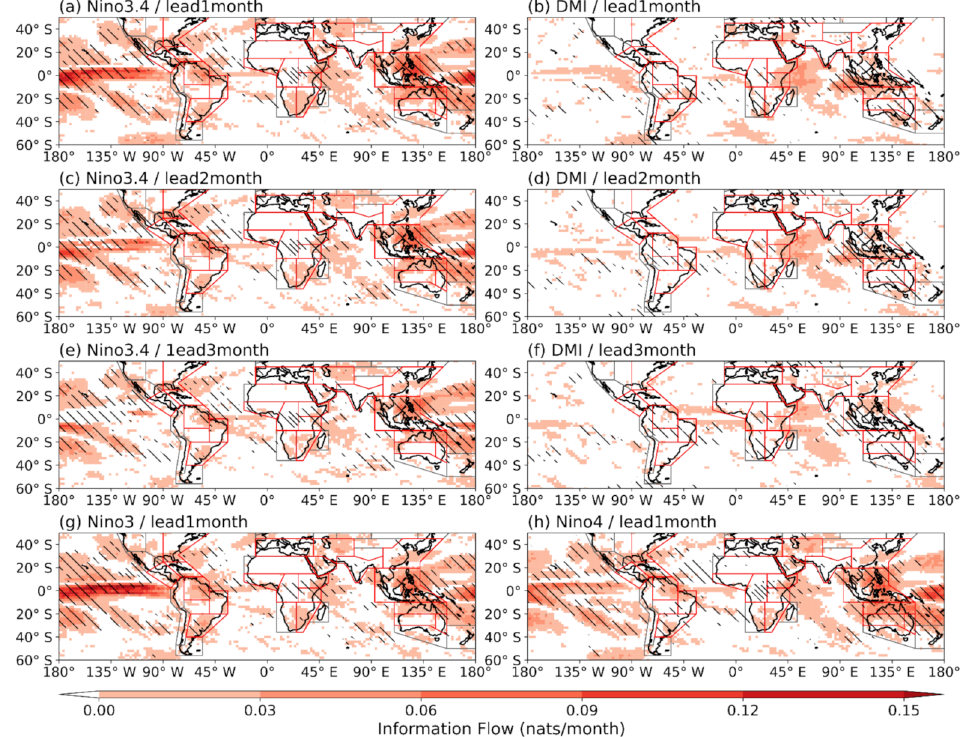
Figure 12. Global information flow from Nino3.4, Nino3, Nino4, and DMI to SPI3 from 1951–2020. The colored areas are statistically significant at the 95% confidence level. ( a , c , e ) are the spatial distribution of the information flow between Nino3.4 and the global gridded SPI3 at lead 1, 2, and 3 months, ( b , d , f ) are the spatial distribution of the information flow between the DMI and the gridded global SPI3 at lead 1, 2, and 3 months, and ( g , h ) are the spatial distribution of the information flow between the Nino3/Nino4 and the gridded global SPI3 at lead 1 month. The slashed areas in ( a , c , e ) are the areas of drought coverage over 0.75 in DJF during El Niño and La Niña. The slashed areas in ( b , d , f ) are the areas of drought coverage increase over 0.25 in SON during combined CP El Niño and pIOD. The slashed areas in ( g ) are the areas of drought coverage over 0.75 in DJF during EP El Niño and La Niña. The slashed areas in ( h ) are the areas of drought coverage over 0.75 in DJF during CP El Niño and La